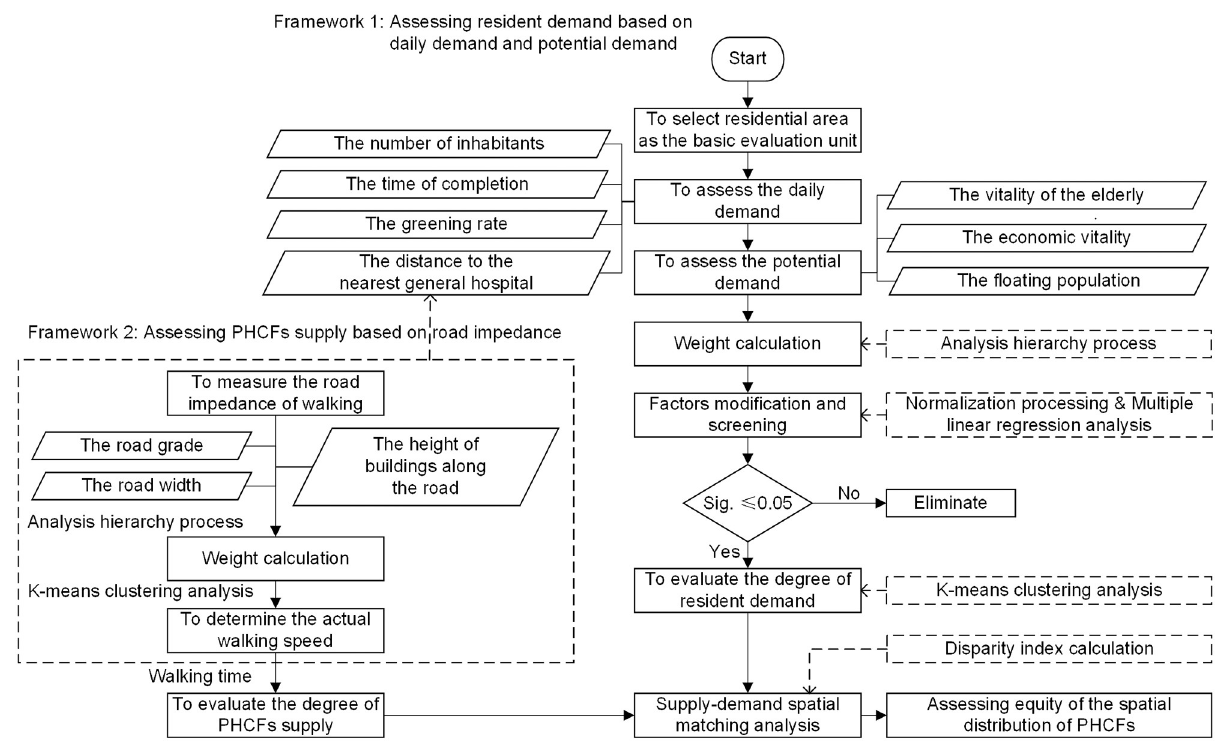
Fig 1. The comprehensive method for assessing equity and analysis